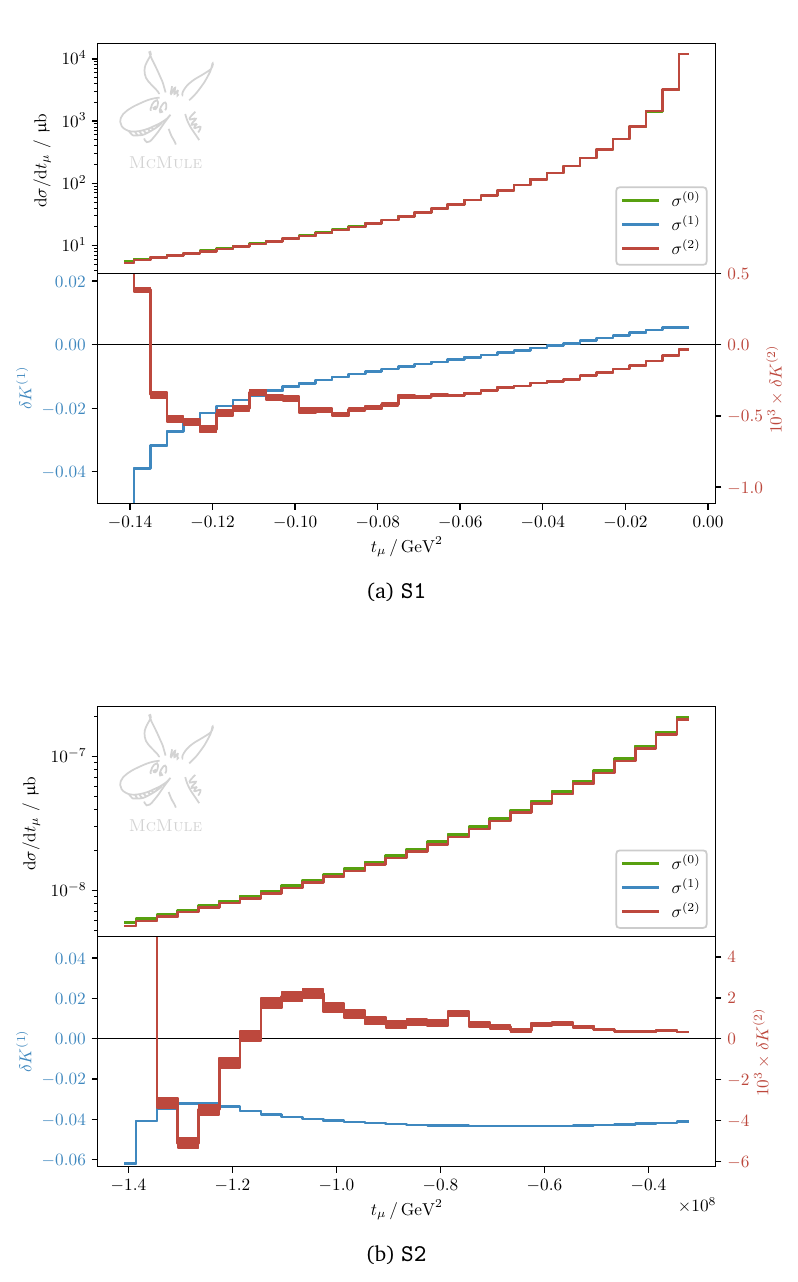
Figure 8: The differential cross section w.r.t. t scenarios S1 (without elasticity cut) and S2 (with elasticity cut). The NLO and NNLO K factors are shown in blue and red,